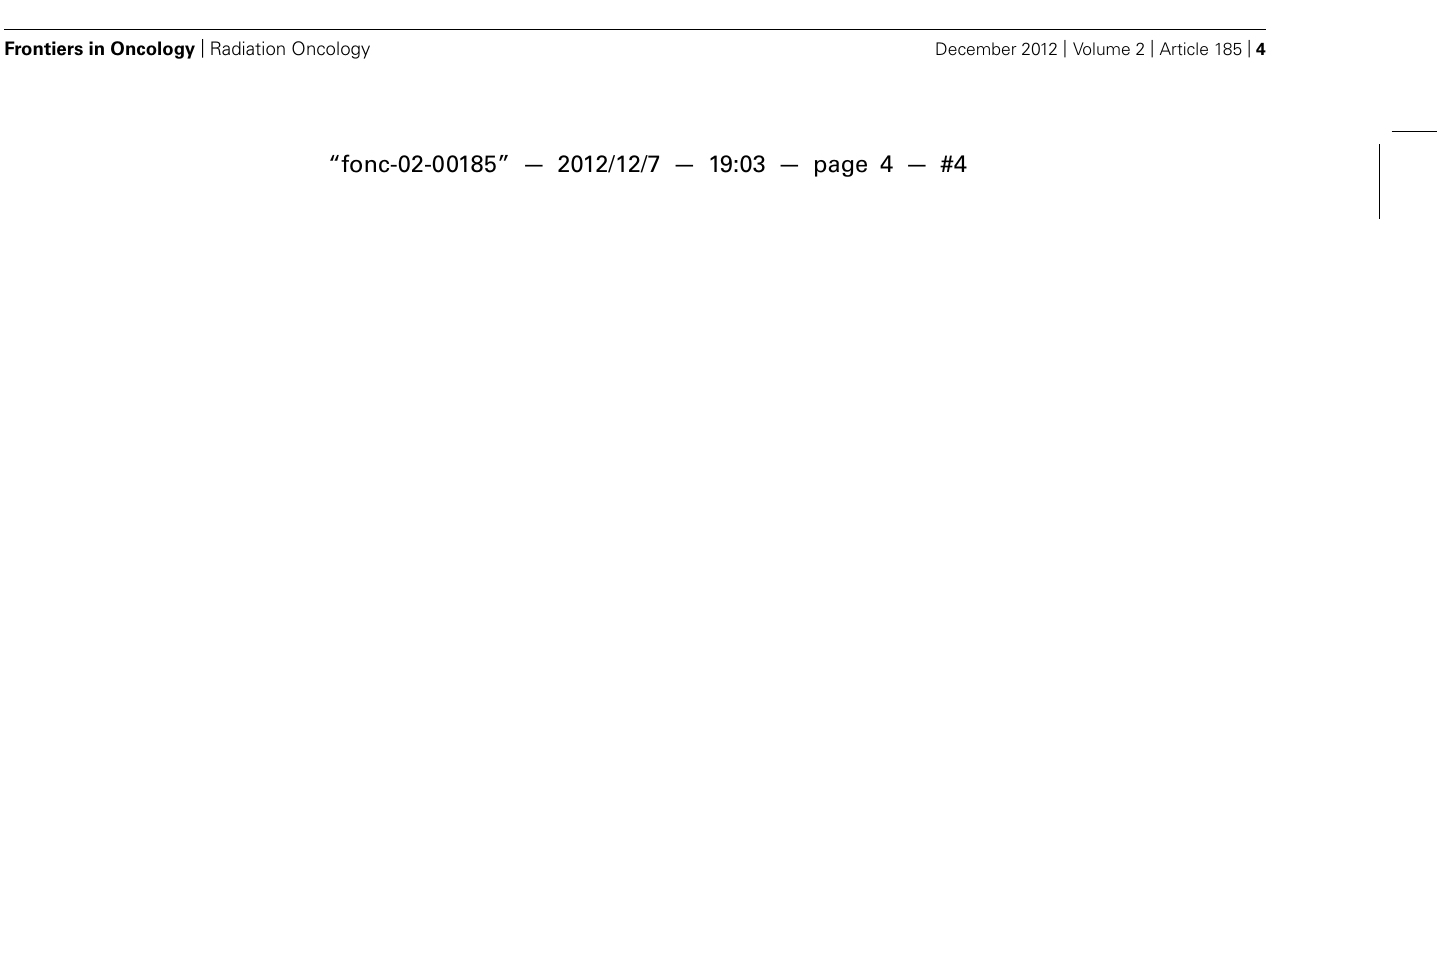
Frontiers in Oncology | Radiation